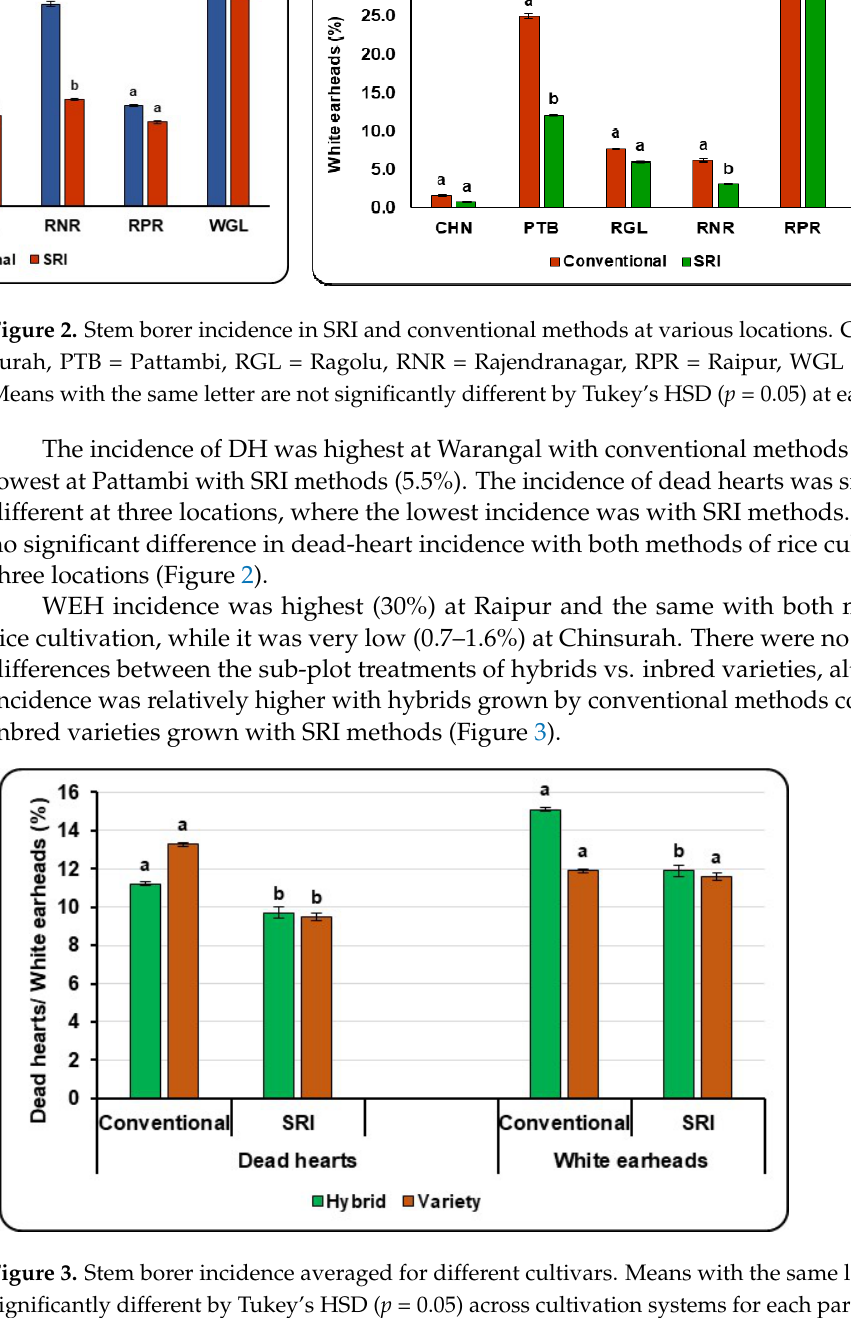
Figure 4. Leaf folder incidence with different methods of rice cultivation and cultivars. Means with the same letter are not significantly different by Tukey’s HSD ( p = 0.05) at each location Caseworm incidence was also observed at two locations where it was at par with both cultivation methods and across cultivars (Figure 5). Gall midge incidence was ob ‐ served at two locations, and the highest damage was observed at Ragolu in hybrid rice with both cultivation methods (Figure 6). The damage was on par in both methods of rice cultivation.